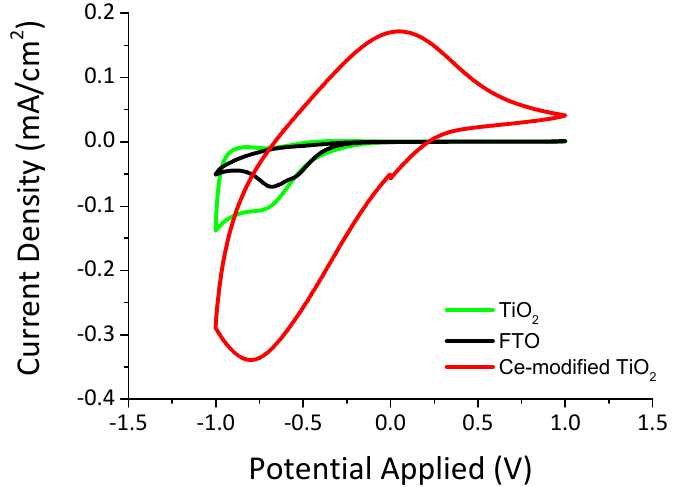
Figure 7. Cyclic voltammograms for SnO 2 :F (FTO), TiO 2 and Ce-modified TiO 2 coated glasses measured at a scan rate 10 mV/s.